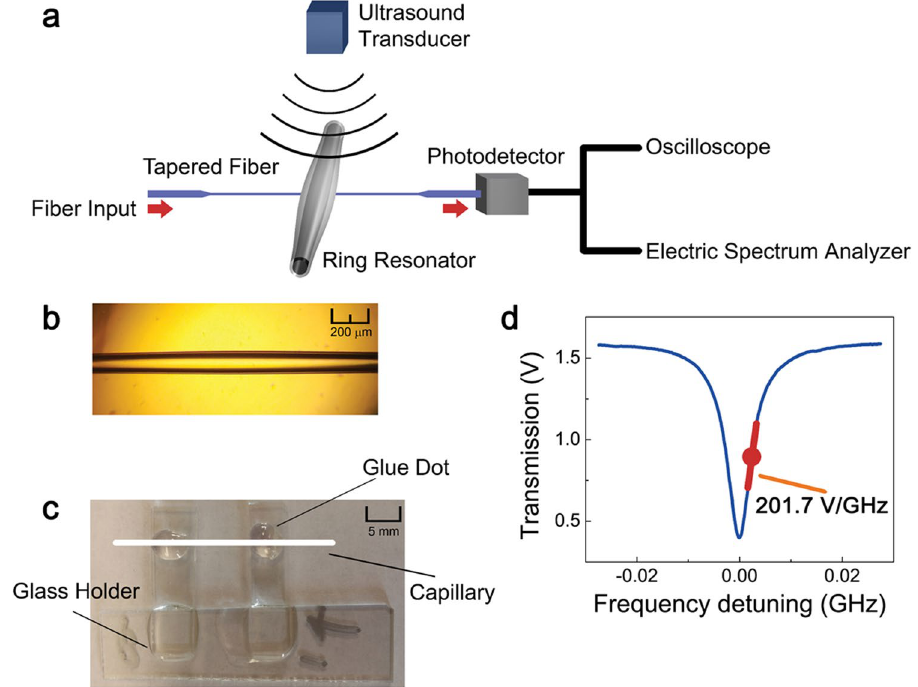
Figure 1. ( a ) Schematic of the experimental setup for pressure wave detection using a capillary-based ring resonator. An optical fiber taper was placed in contact with the capillary to couple the laser light around 1550 nm from a tunable laser into the WGM of the ring resonator. The transmitted light was detected by a photodetector (either DC-coupled or AC-coupled) and analyzed by an oscilloscope and a spectrum analyzer. An ultrasound transducer (800 kHz) was placed 2 cm above the resonator, aiming at the center of the resonator. ( b ) Photograph of the capillary-based bottle-shaped ring resonator. ( c ) Photograph showing the capillary-based ring resonator placed on a holder and secured by two glue dots. The distance between the two glue dots could vary, but did not affect the pressure measurement. The minimum distance tested was 3 mm. The white line indicates the position of the capillary. ( d ) Transmission signal shows that the Q-factor of the ring resonator (65 μ m in outer radius and 10 μ m in wall thickness at the most-bulged part) was 3.5 × 10 7 . The red dot shows the spectral position where the laser was fixed. Slight WGM spectral shift resulting from a pressure wave causes the transmission intensity to